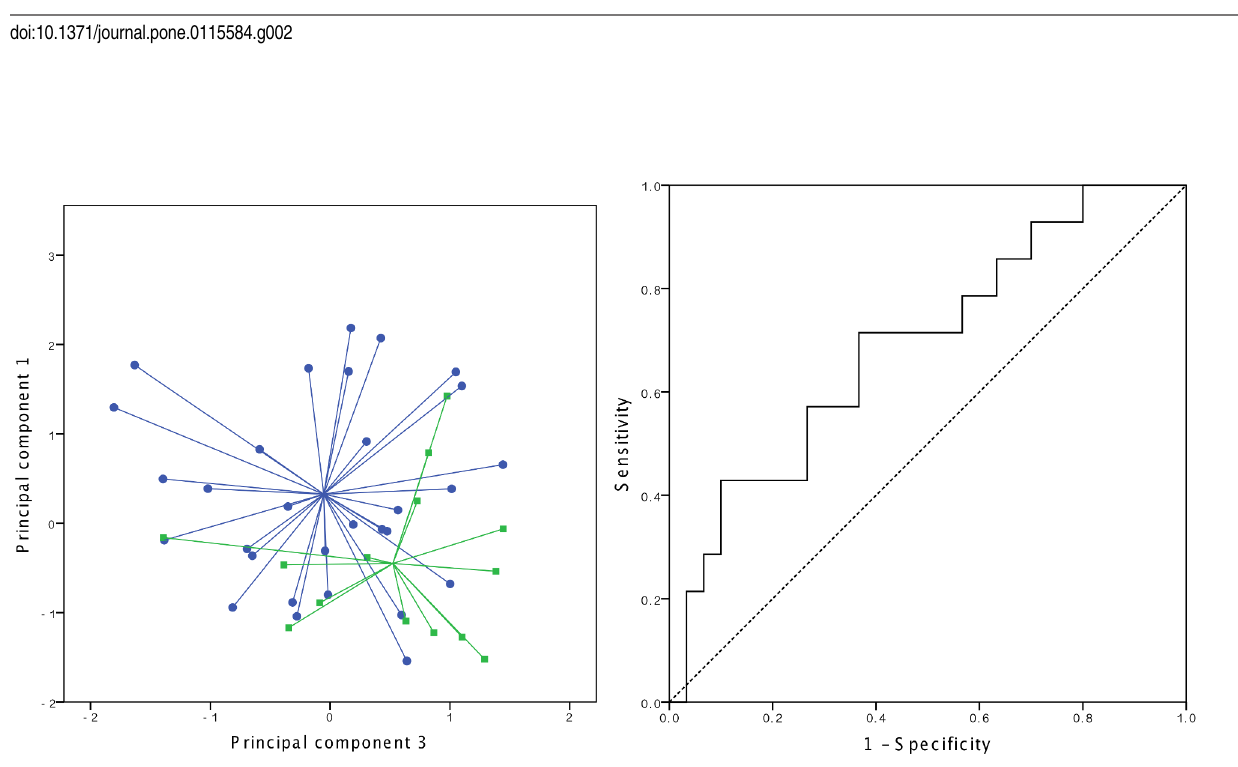
Fig. 3. Discrimination of CF patients with a chronic P. aeruginosa (PA) infection vs. CF patients without a chronic infection. Left: two-dimensional principal component plot visualizing the PA infected patients in green and the non-chronically infected CF patients in blue. Right: ROC curve for the discrimination of PA infected from the non-chronically infected CF patients (AUC 5 0.69).